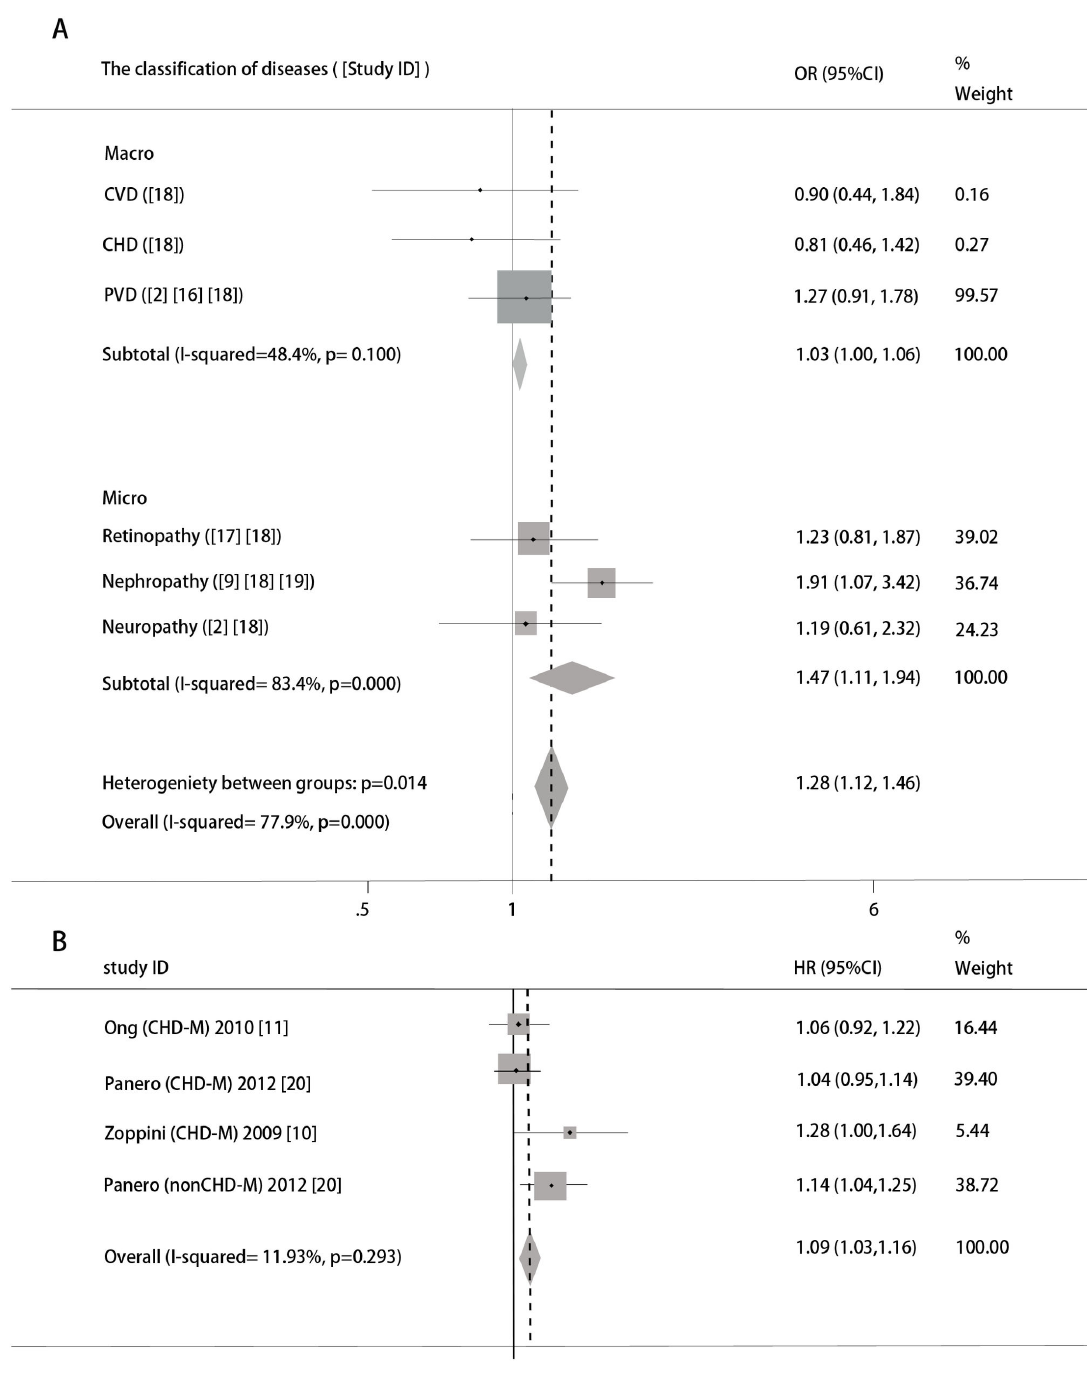
Figure 2. Forest plot of relationship between SUA and vascular complications and mortality in T2DM. The area of each square is proportional to study weight. The diamonds indicate overall estimates (with corresponding 95% CIs). A. Forest plot of relationship between SUA and type 2 diabetic vascular complications. The grey squares and horizontal lines indicate study-specific ORs (with corresponding 95% CIs) for risk of diabetic vascular complications for 0.1mmol/l increase in SUA. The number in the brackets indicated Study ID. B. Forest plot of relationship between SUA and type 2 diabetic mortality. The grey squares and horizontal lines indicate study-specific HRs (with corresponding 95% CIs) for risk of diabetic mortality for 0.1mmol/l increase in SUA. CHD-M and non CHD-M indicated mortality caused by cardiovascular and non-cardiovascular complications. The number in the brackets indicated Study ID. doi: 10.1371/journal.pone.0078206.g002 PLOS ONE |